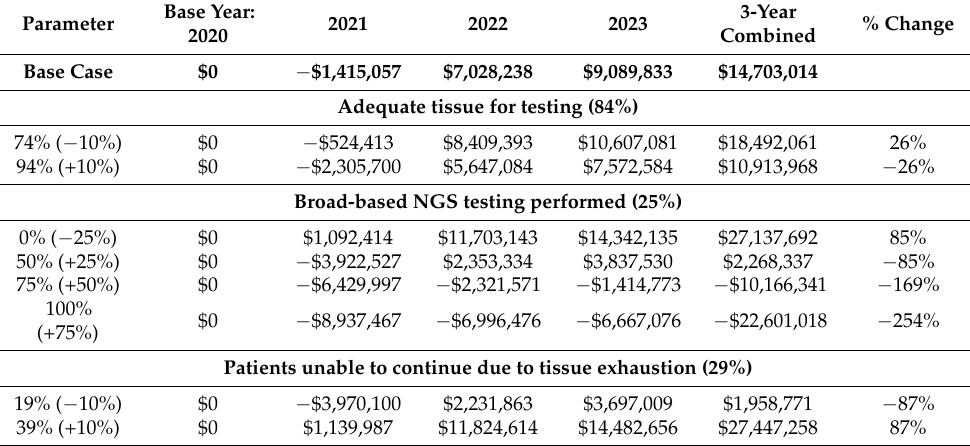
Table 11. One-way sensitivity analysis